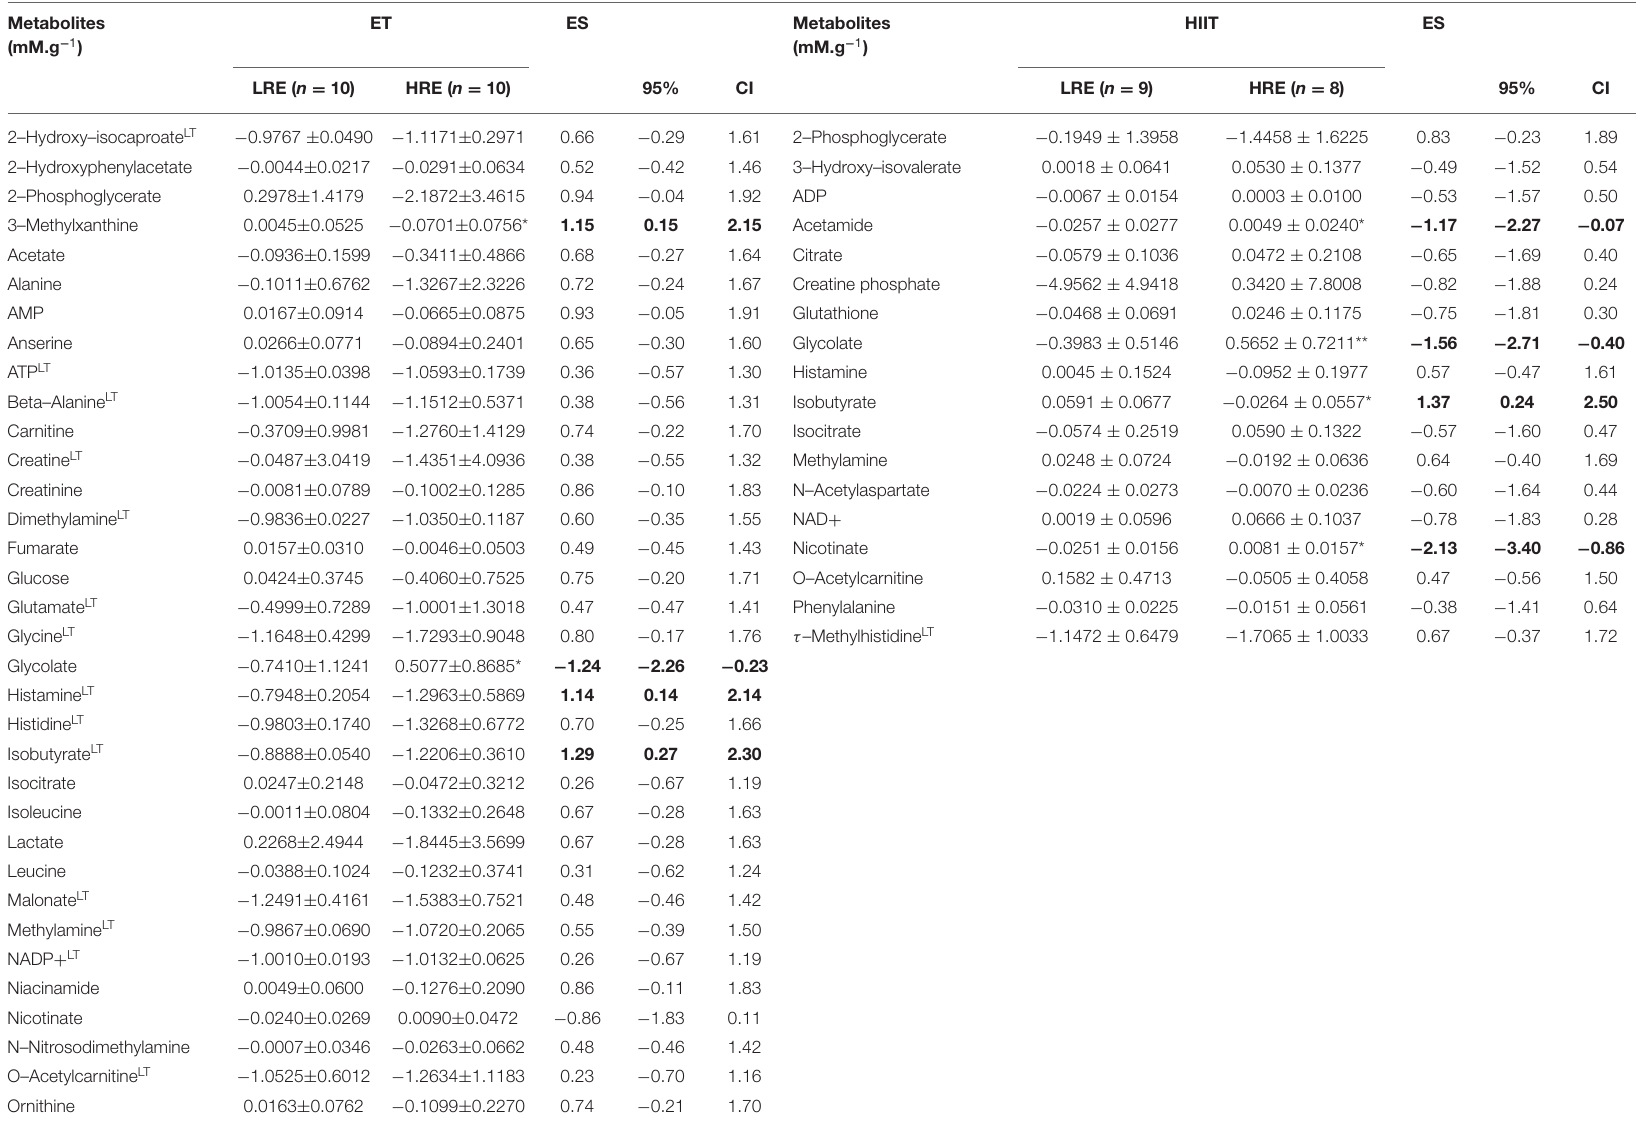
TABLE 4 | Comparison of the pretraining to post–training changes in skeletal muscle metabolites’ concentration levels between low responders (LRE) and high responders (HRE) to the ET and HIIT programs in the TIMES study. Metabolites (mM.g − 1